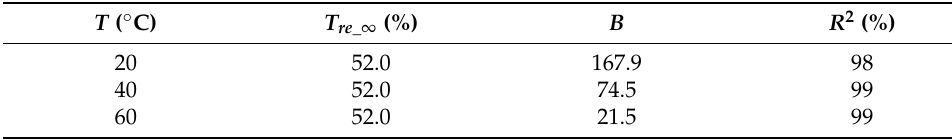
Figure 24. 𝑇 (cid:3045)(cid:3032) − 𝑡 fi(cid:308)ing curves based on the fourth prediction model: ( a ) G1; ( b ) G2. Figure 24. T re − t fitting curves based on the fourth prediction model: ( a ) G1; ( b ) G2. Table 14. Determined values of 𝑇 (cid:3045)(cid:3032)_(cid:2998) and 𝜏 (G1). Table 14. Determined values of T re _ ∞ and τ (G1).